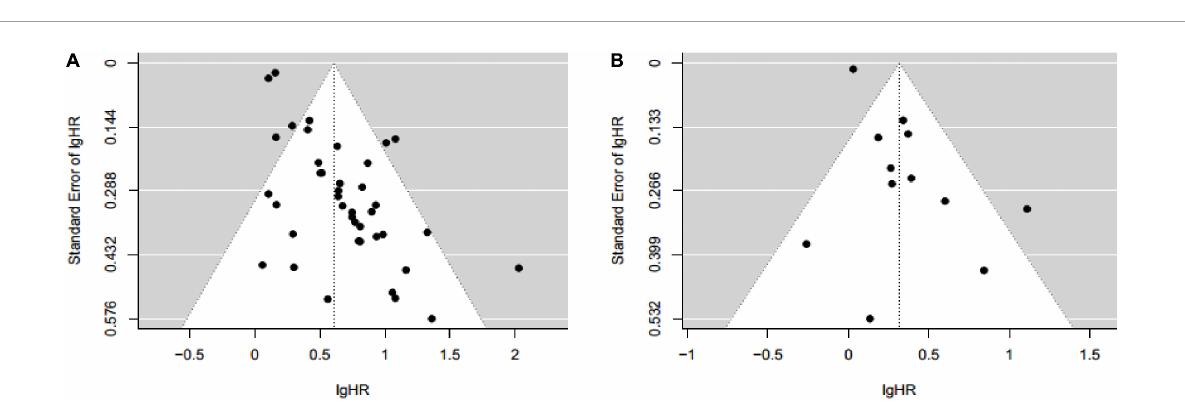
FIGURE5 Funnel plot for assessing publication bias between sarcopenia with overall survival (A) and progression free survival (B) in patients with hepatocellular